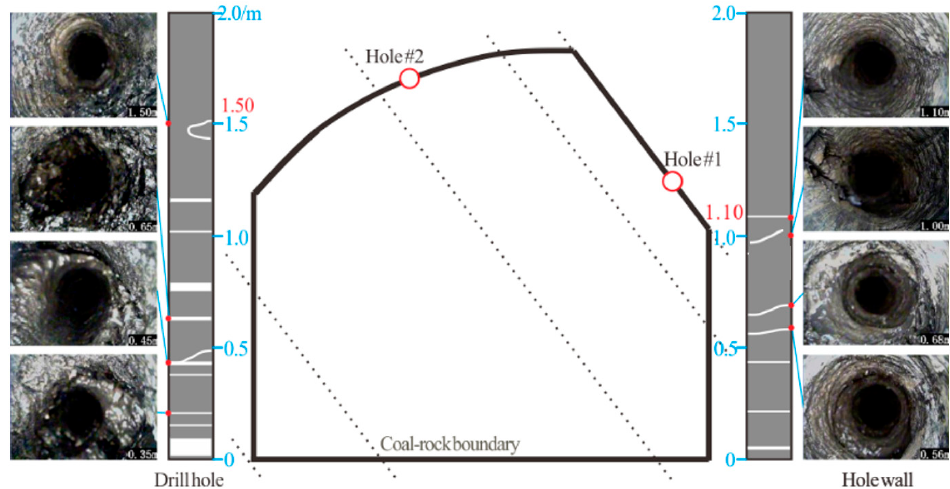
Figure 17. Peeping results of the surrounding rocks under the new support.